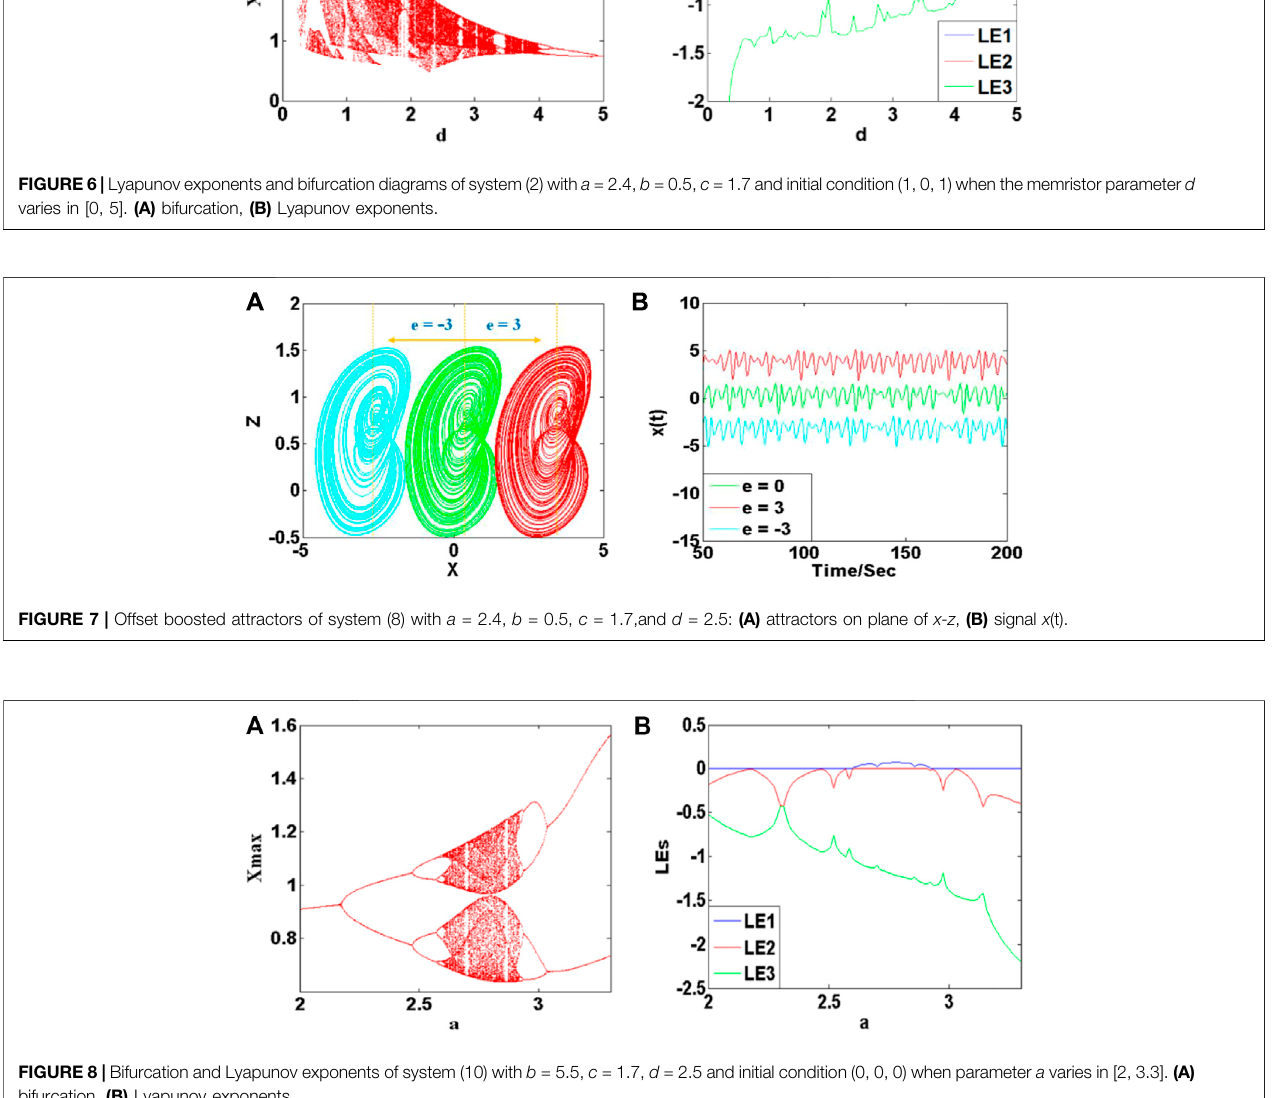
Frontiers in Physics |